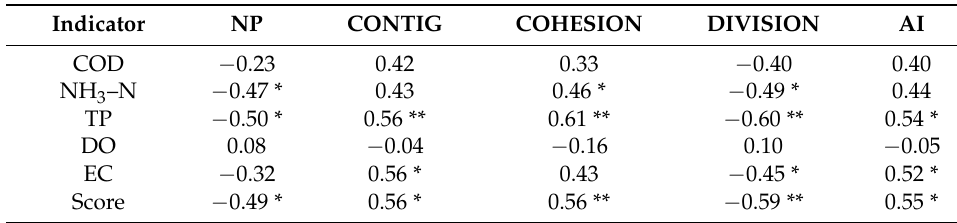
Table 5. Correlations between landscape configuration indices of the urban area and surface water quality indicators (2000 m radius).